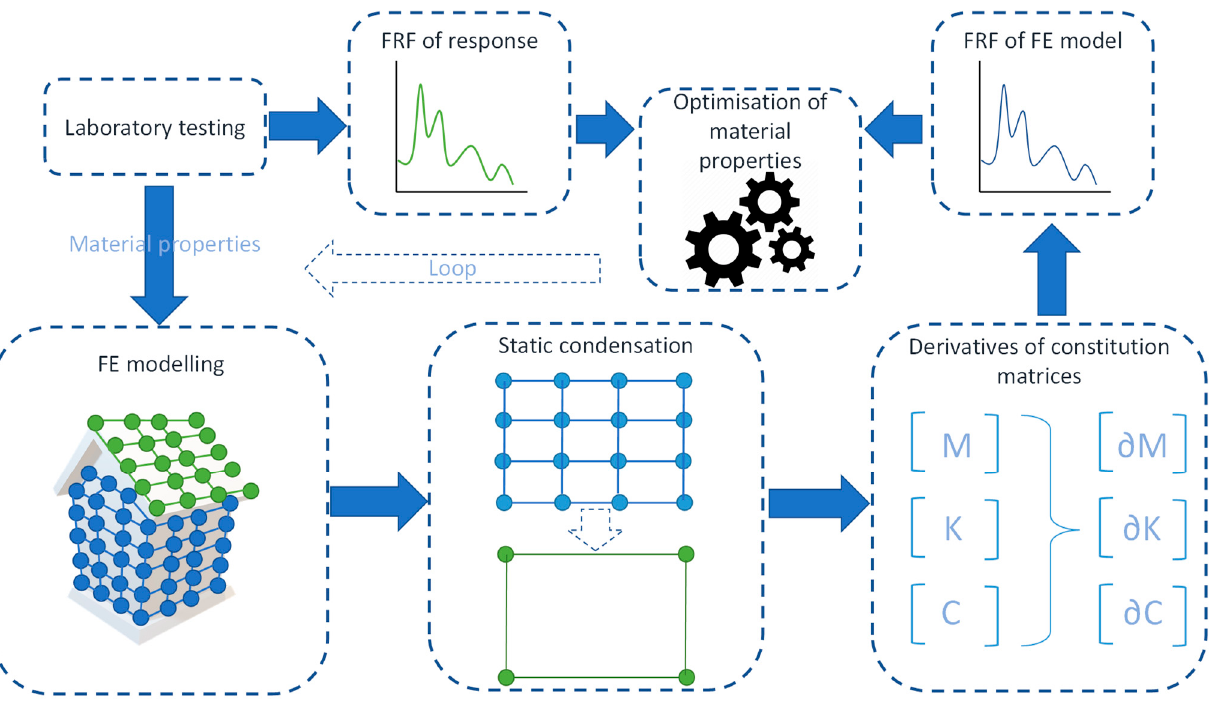
Figure 5. Flowchart of the calibration procedure.